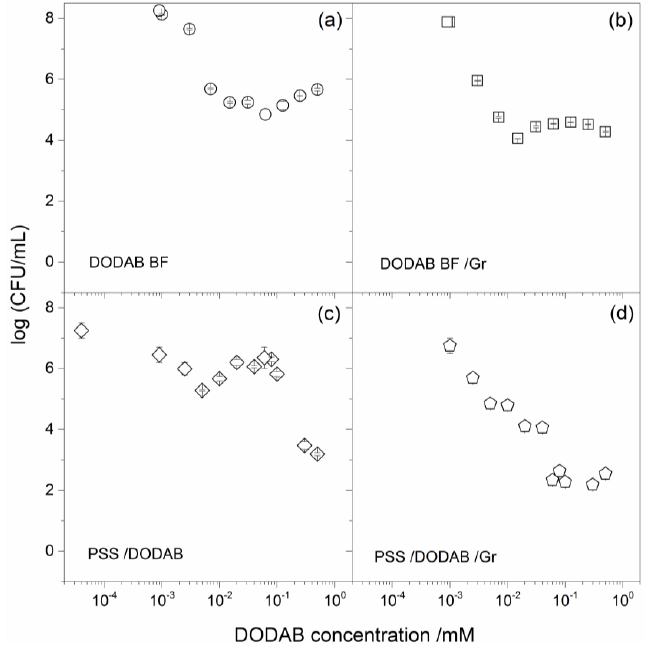
Figure 5. The microbicidal activity of biomimetic cationic NPs of PSS/DODAB and PSS/DODAB/Gr against S. aureus . Cell viability of S. aureus , in log (CFU/mL), as a function of DODAB concentration for different DODAB assemblies: ( a ) DODAB BF; ( b) DODAB BF/Gr. where Gr concentration is 10% of [DODAB]; ( c ) PSS/DODAB; ( d ) PSS/DODAB/Gr. where Gr concentration is 10% of [DODAB]. Initial cell concentration was in the range (2 – 20) × 10 7 CFU/mL. The ratio between DODAB and NP concentration was 10 µM DODAB per 2.4 × 10 10 PSS particles/mL in ( c ) and ( d ). DODAB and Gr concentration varied with the particle number density in ( c ) and ( d ). After 1 h of interaction between cells and assemblies, dilution and plating of the mixtures allowed CFU counting.